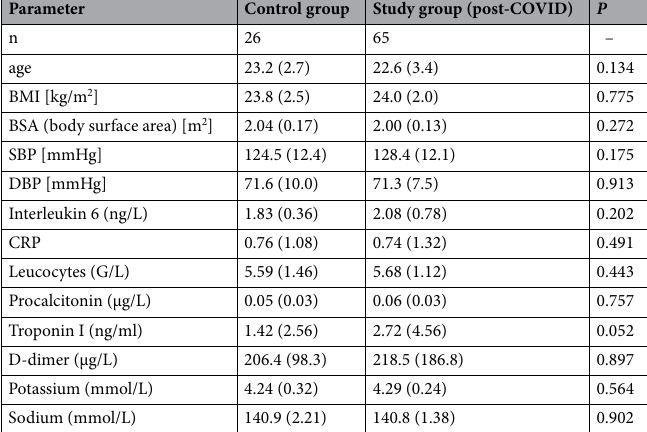
Table 1. Baseline characteristics of the study